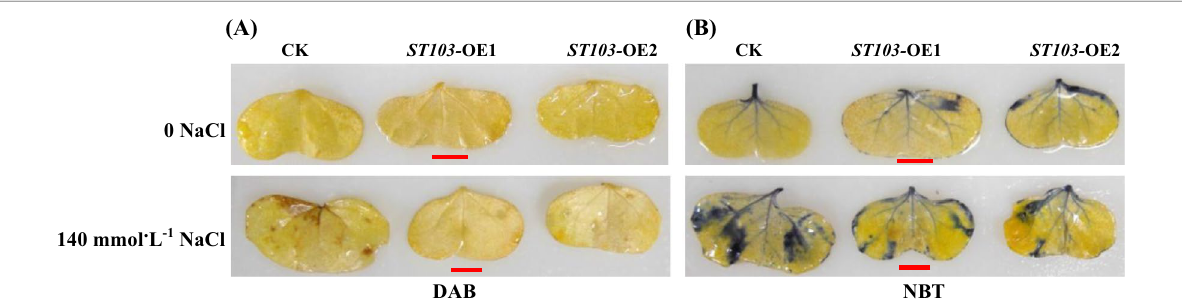
Fig. 4 The histochemical staining analysis with DAB (3,3’ diaminobenzidine) and NBT (nitroblue tetrazolium chloride); the leaves of CK and transgenic cotton lines ( ST103- OE1 and ST103- OE2) were grown in the soil for a week, moved to the hydroponic culture for 4 days and treated with